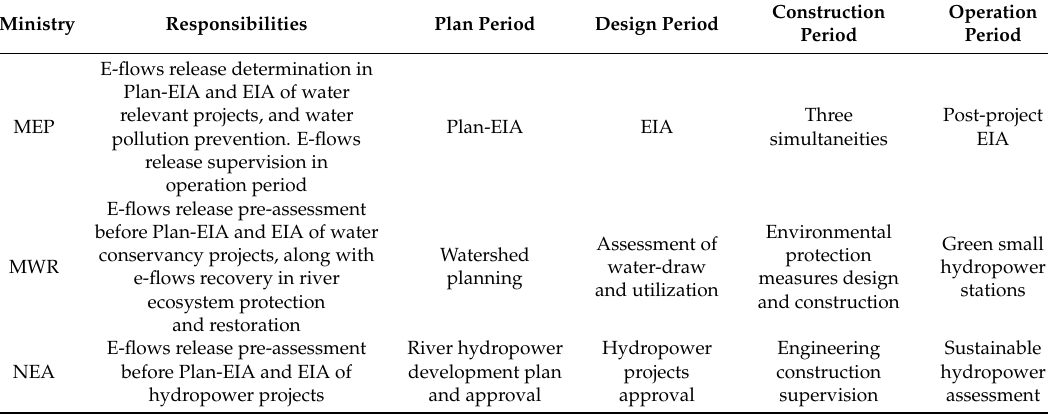
Table 1. Relevant ministries for environmental flows (e-flows) and their